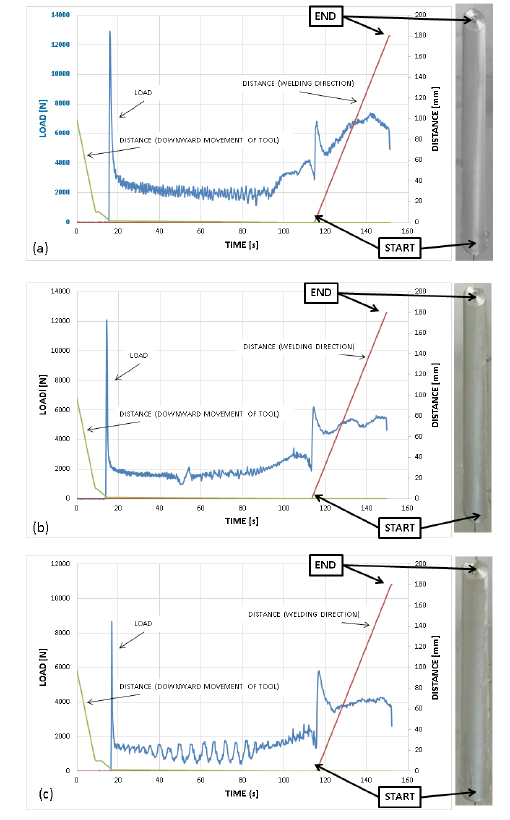
Figure 1. Graphical representations of load and distance as a function of welding time at different rotational speeds of (a) 1,000 rpm, (b) 1,500 rpm and (c) 2,000 rpm at a constant welding speed of 300 mm/min. A macrography of the welding region showing the start and endpoints of welding in the plate is also